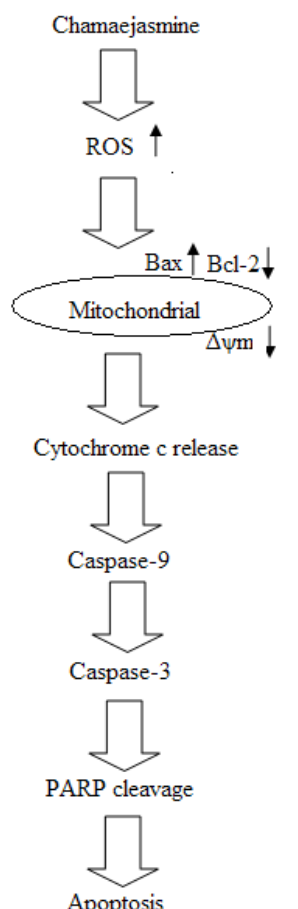
Figure 10. Signaling pathway of chamaejasmine-induced apoptosis in A549